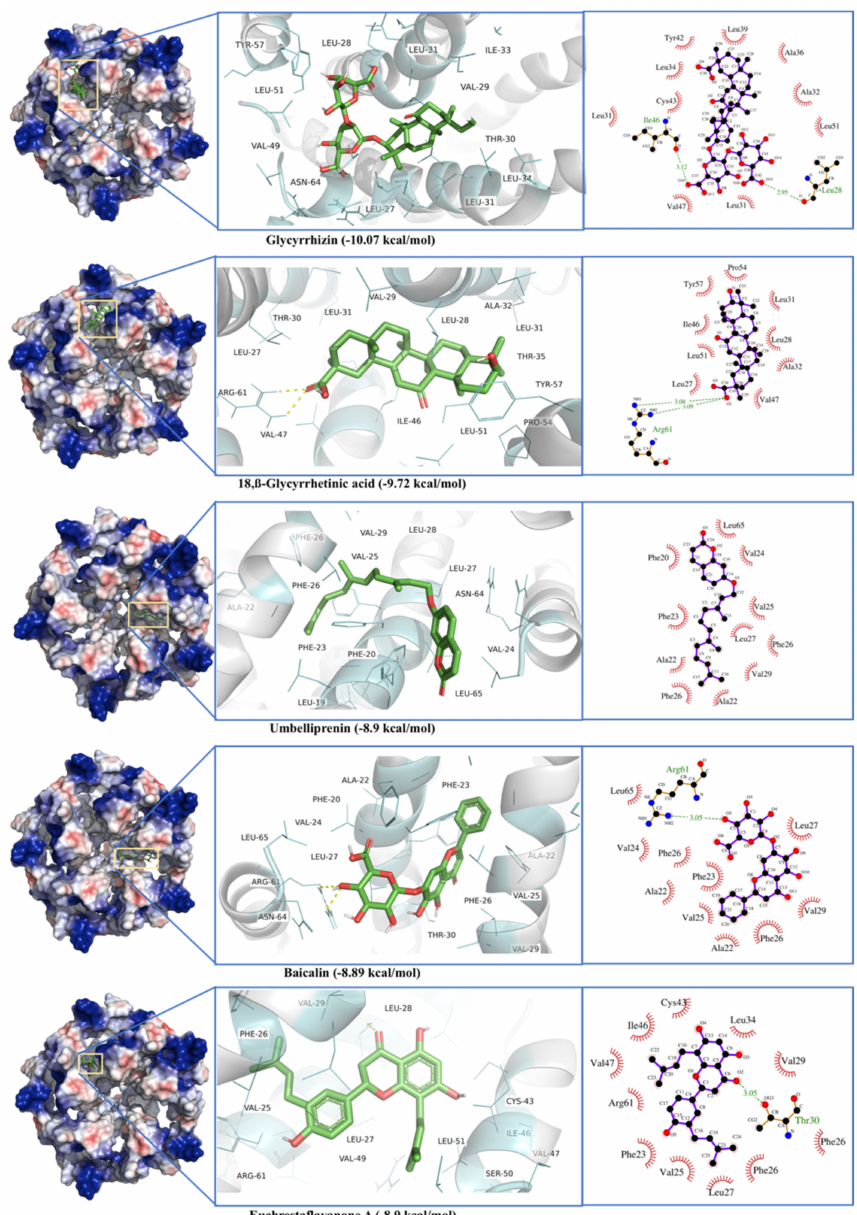
Figure 12. Glycyrrhizin, β -Glycyrrhetinic Acid, Solophenol A, Hesperidin, and Baicalin docking to helicase of SARS-CoV-2 Spike protein